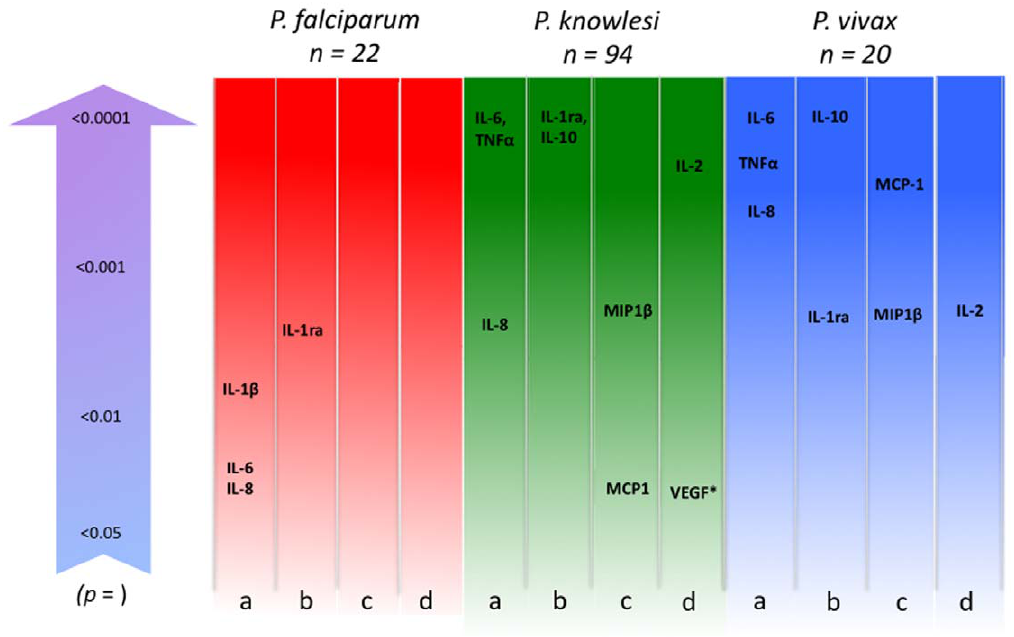
Figure 2. Comparison of significant ( p= , 0.05)correlations between P.falciparum,P.knowlesi and P.vivax parasitaemia and immune mediators. Columns show cytokines and chemokines divided by function or cell source; a) pro-inflammatory, b) anti-inflammatory, c) macrophage/ dendritic cell derived and d) IL-2 and VEGF growth factors. The arrow shows level of significance of each association (Spearman’s rank correlation test). * VEGF is inversely associated with P. knowlesi parasitaemia.